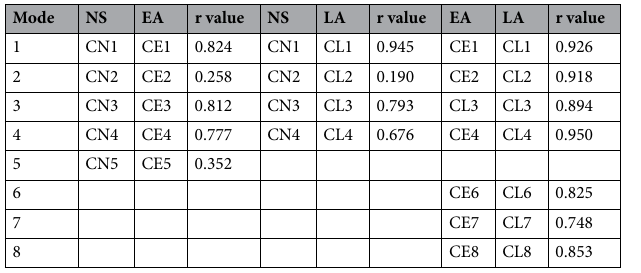
Table 3. Similarity between the activation of across the novel slips (NS), early-adapted slips (EA), and late- adapted slips (LA) for each mode in common (Mode 1–8).